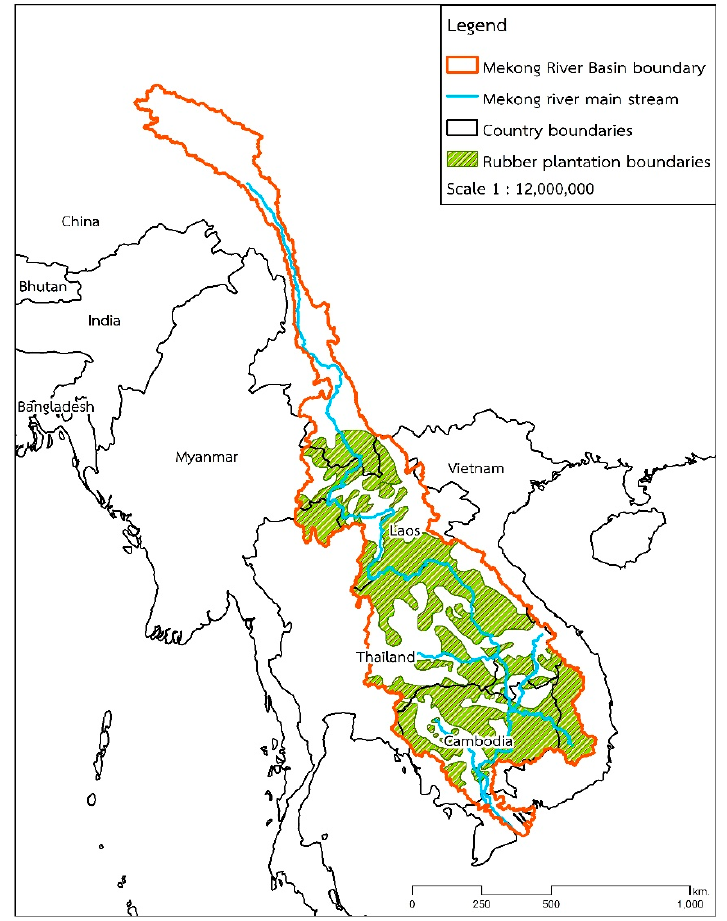
Figure 1. Rubber plantations in the Lower Mekong Basin (LMB) and Mekong River Basin (MRB) in the inlet map. Source: Rubber plantations redrawn from [39]; Country boundary redrawn from [40]; MRB boundary from redrawn [41].